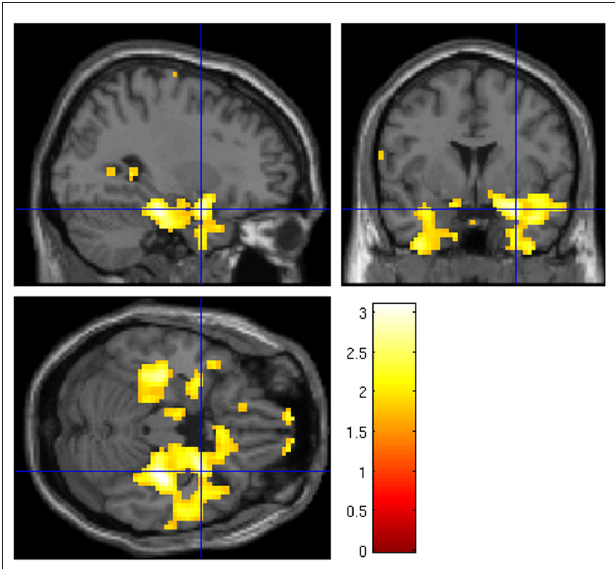
FIGURE 4 | Whole brain group analysis of the contrast “UP” against “DOWN” regulation at p < 0.05 uncor. The blue crosshairs mark the right amygdala MNI coordinate [30, 2, − 23]. The scale represents t -values ( df =